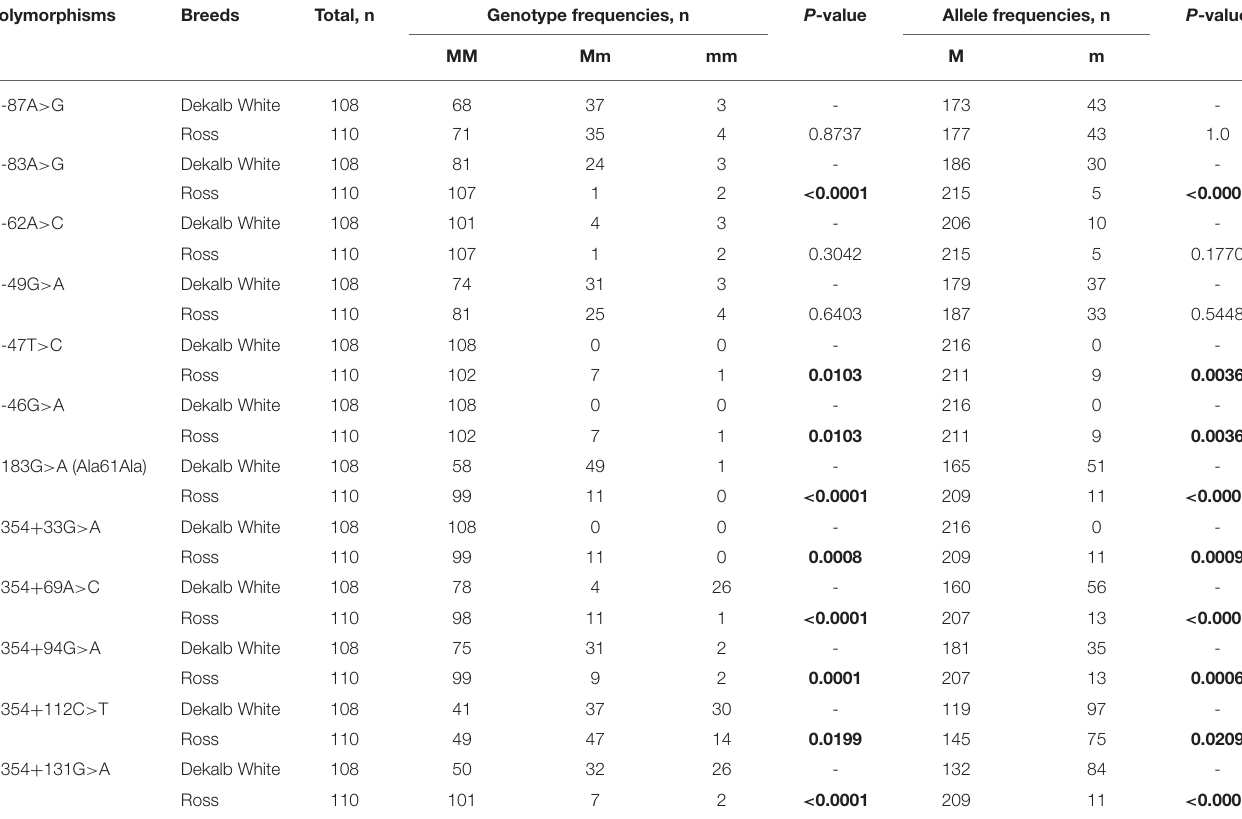
TABLE 1 | Genotype and allele frequencies of shadow of prion protein gene ( SPRN ) polymorphisms in chickens.